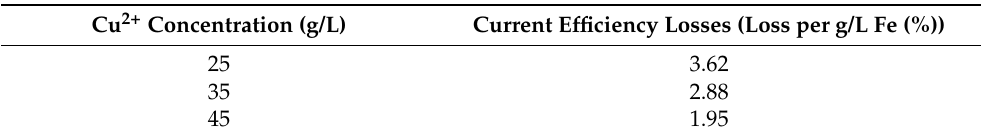
Figure 11. Effect of Fe 3+ and Cu 2+ concentration on Cu current efficiency. (Conditions: current density 250 A/m 2 , temperature 40 ◦ C, electrolysis time 4 h). Table 2. The effect of copper concentration on current efficiency loss per g/L of Fe after the elec- trowinning